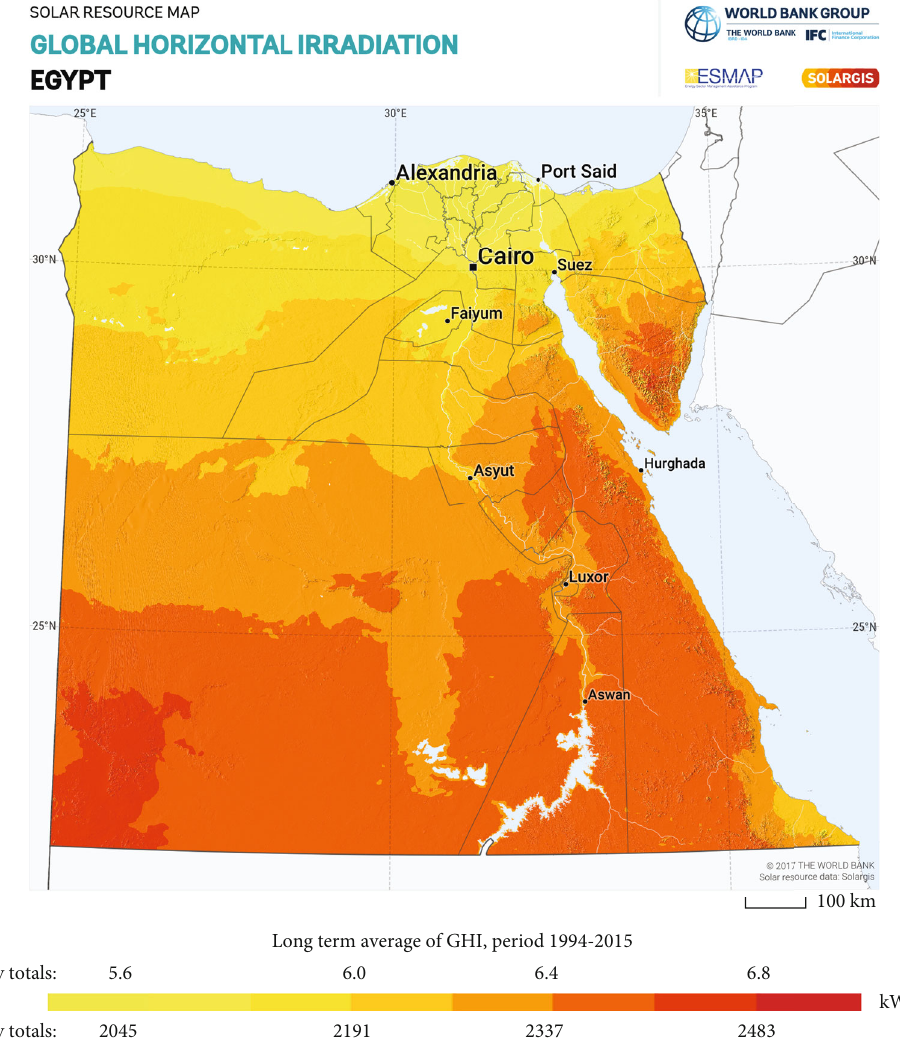
Figure 8: Average daily GHI solar irradiation in kWh/day [41].